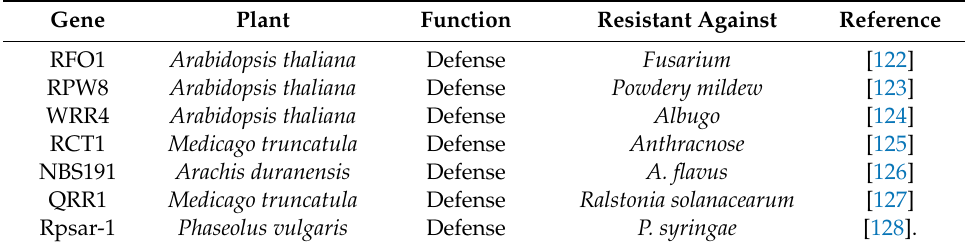
Table 2. NB-LRRs from di ff erent plants and their role against diverse pathogens. Gene Plant Function Resistant Against Reference RFO1 Arabidopsis